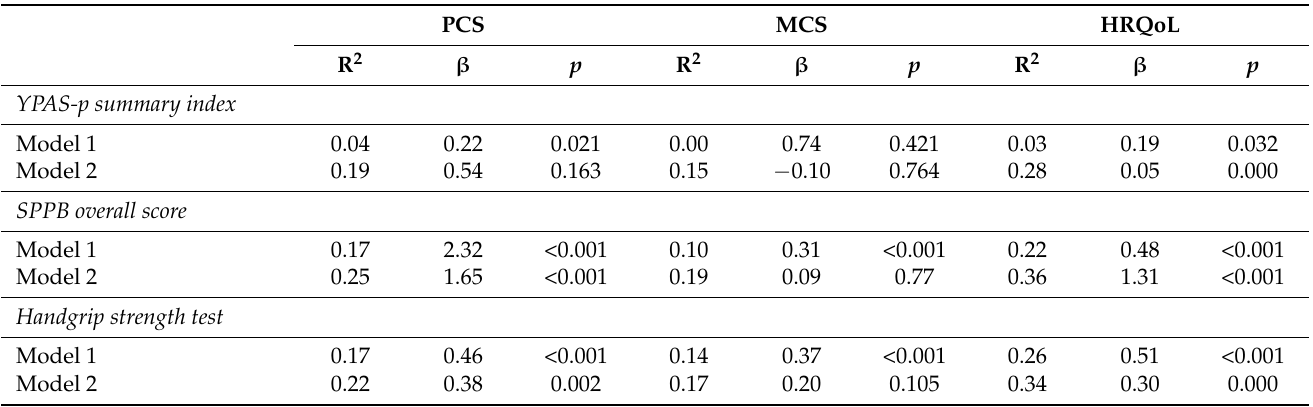
Table 5. Regression models for physical-functional fitness tests (SPPB and HGT) and physical activity levels (YPAS-p indexes) predicting health-related quality of life of older participants living in rural areas ( n =